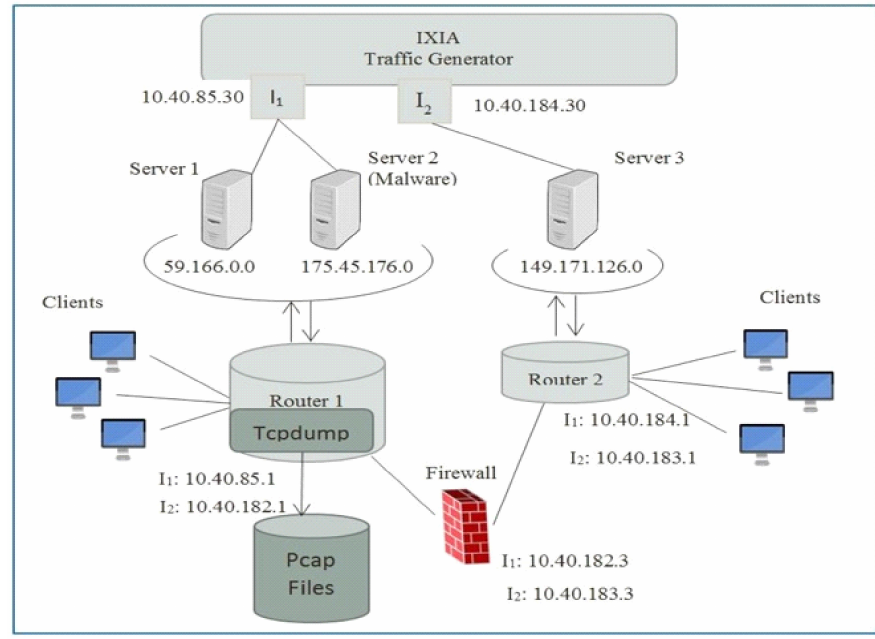
Figure 14. Tool for software implementation of the “IXIA Perfect Storm” cyberattack. Abnormal traffic included 55.0% of cyberattacks, which are divided into ten types, namely: fuzzers ( ε 1 ), analysis ( ε 2 ), backdoors ( ε 3 ), DDoS ( ε 4 ), exploits ( ε 5 ), generic ( ε 6 ), reconnaissance ( ε 7 ), shellcode ( ε 8 ), worms ( ε 9 ), and “scanning the network and its vulnera- bilities” ( ε 10